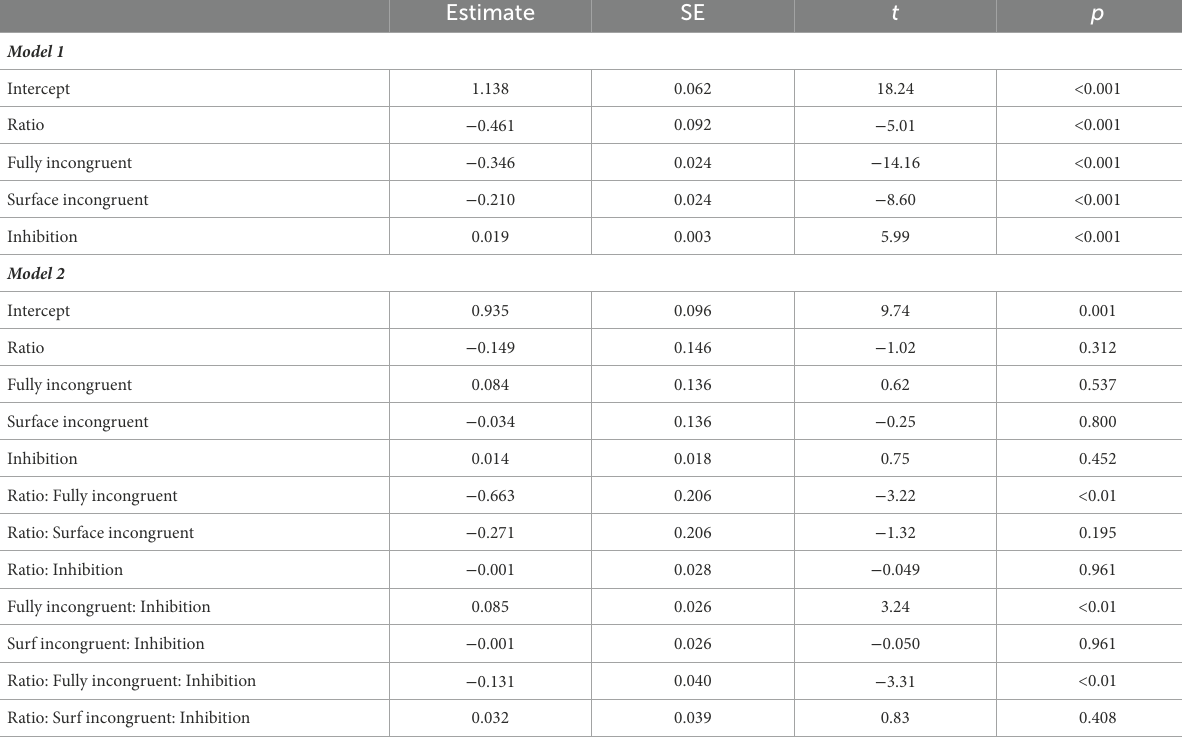
TABLE 3 Results of the two-level logistic mixed models predicting dot’s comparison accuracy. Estimate SE t p